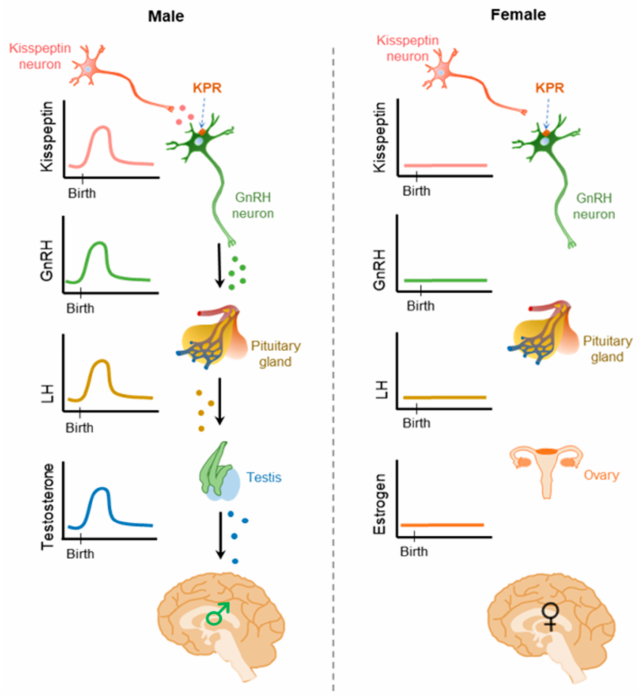
Figure 7. Neonatal testosterone surge in males. In the males, there is a transient increase of testos- terone level soon after the birth. This event, also known as “mini-puberty” is driven by male-specific neonatal kisspeptin (KP) neurons and results in the activation of the hypothalamic-pituitary axis. There is no parallel phenomenon in the females. This neonatal testosterone surge (NTS) is critical for the establishment sexual dimorphism in the AVPV/ PeN nuclei depleting the KP neurons in males. The NTS is also important for the normal development of male reproductive